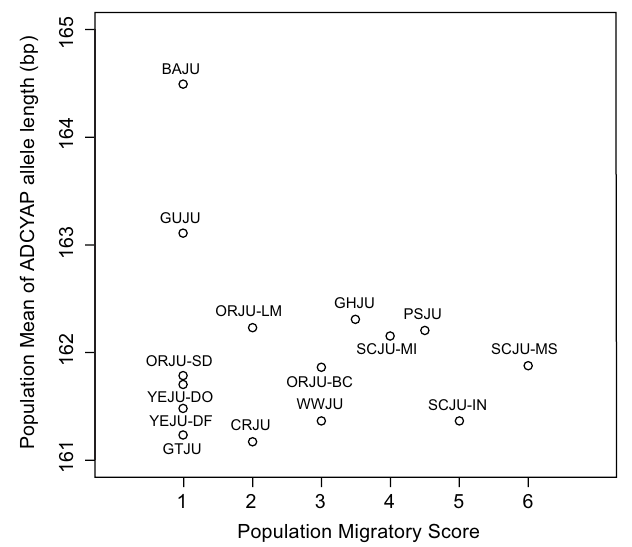
Figure 1. ADCYAP1 allele length and migratory status. No correlation was found between allele length and migratory score (Spearman’s correlation, p > 0.05).